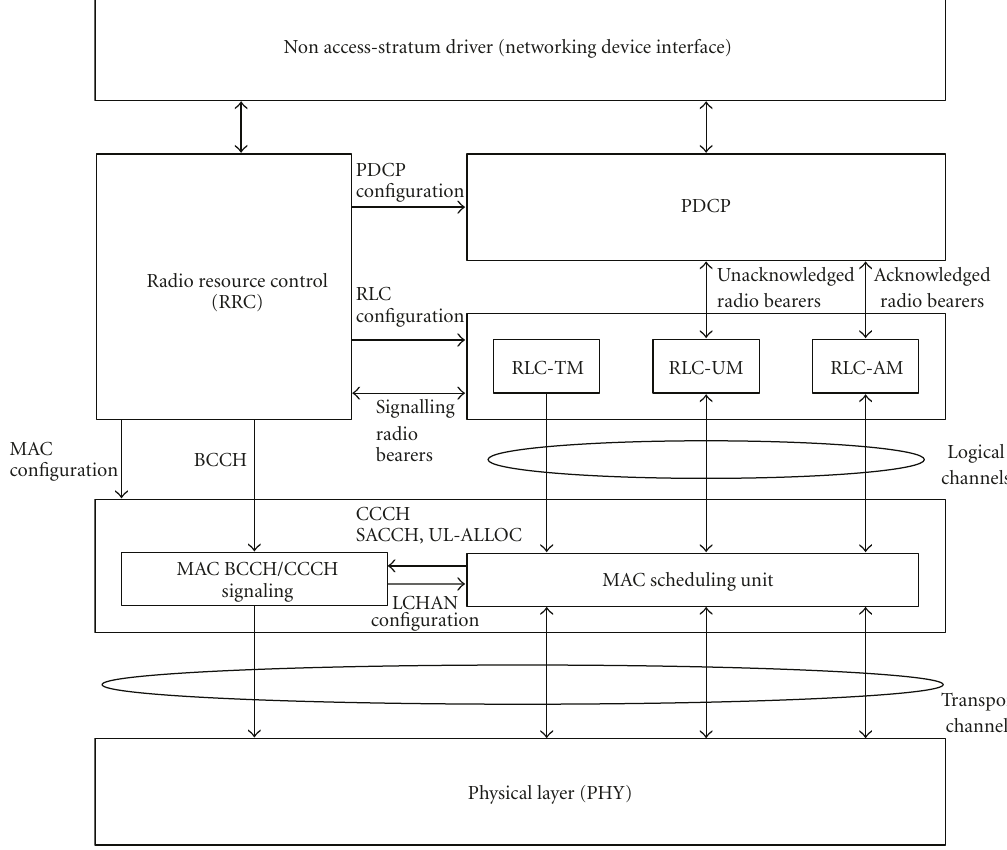
Figure 3: OpenAirMesh CH Layer 2 Protocol Stack.